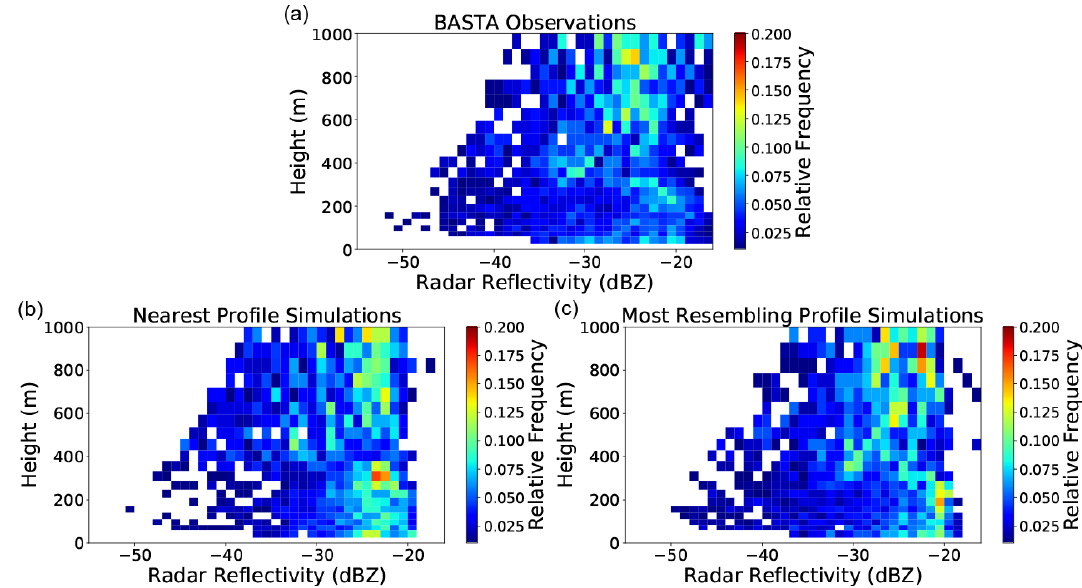
Figure 9. CFADs of reflectivity observed and simulated from the nearest corresponding and most resembling profiles for the period 1 Novem- ber 2018 to 19 February 2019 where cloud is seen in all three